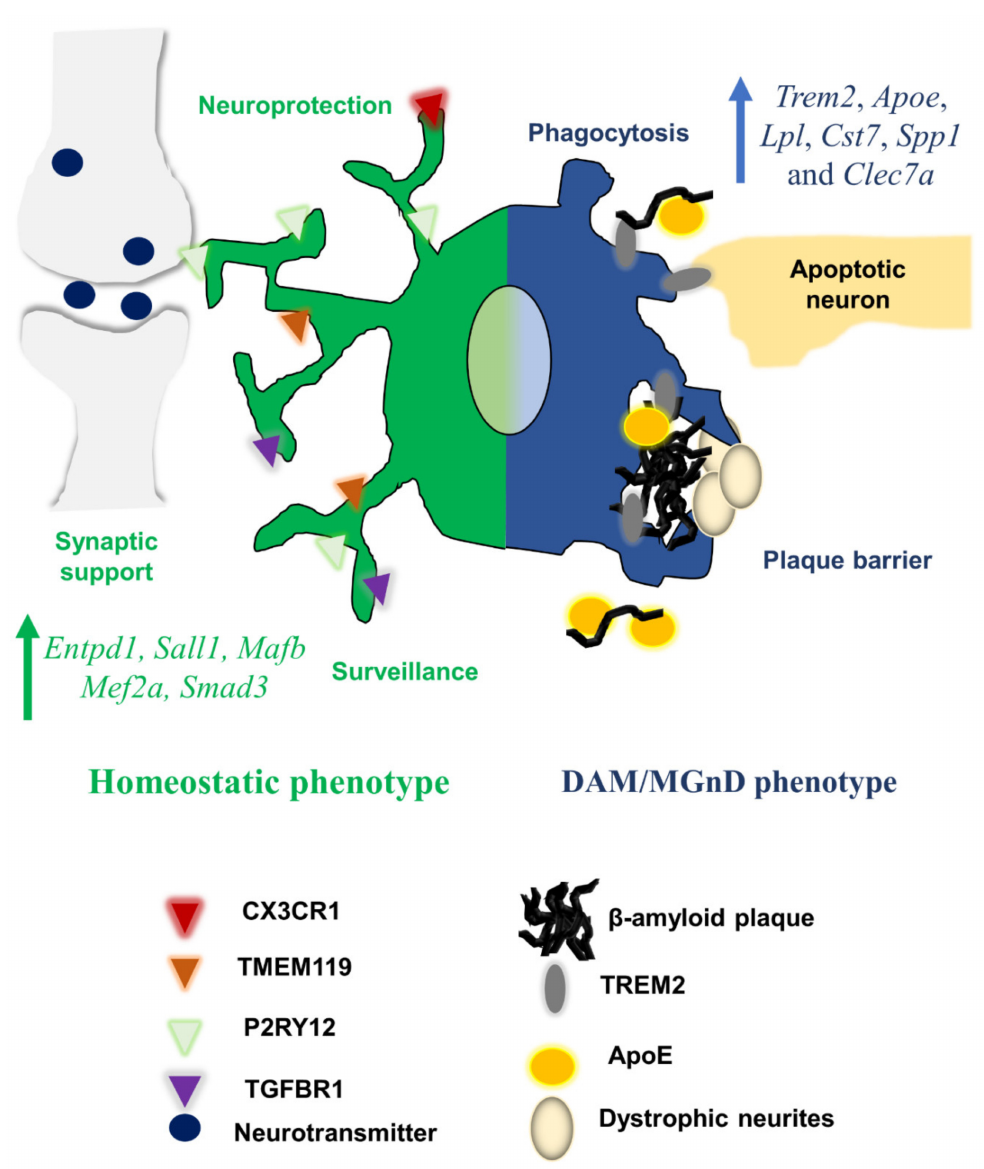
Figure 1. Regulation of the homeostatic and DAM/MGnD phenotypes. The homeostatic phenotype (green) is associated with phenotypes associated with microglial-mediated neuroprotection, synaptic support and immune surveillance. Surface receptors are upregulated in the homeostatic state, such as CX3CR1, TMEM119, P2RY12, TGFBR1 and CD39, encoded by Entpd1 , all of which facilitate homeostatic responses. Homeostatic microglia display key transcription factors, such as Sall1, Mef2c and Smad3. Onset of neurodegenerative-associated pathology such as A β , or apoptotic neurons, triggers downregulation of homeostatic surface receptors and upregulation of the DAM/MGnD phenotype (blue)—the latter associated with markers Trem2 , Apoe , Lpl , Cst7 , Spp1 and Clec7a . Phagocytosis of apoptotic neurons and phagocytosis of A β is performed via TREM2- or ApoE-mediated recognition signals in microglia. ApoE and TREM2 coordinate expression of DAM/MGnD genes, as well as facilitate formation of the microglial-mediated plaque barrier to protect neighboring neurons from dystrophic neurite